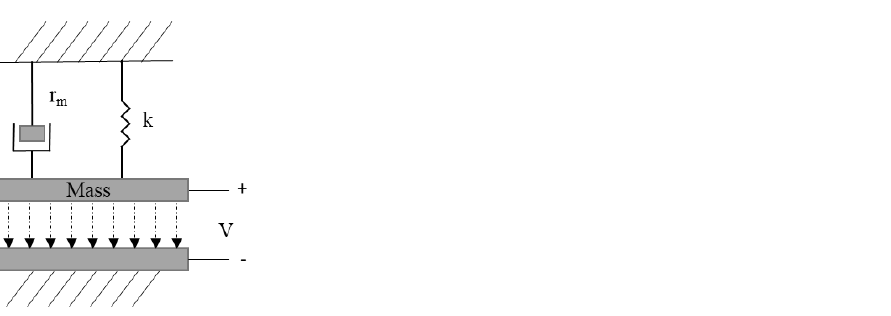
Figure 3. Schematic view of a microcantilever structure (image not to scale).